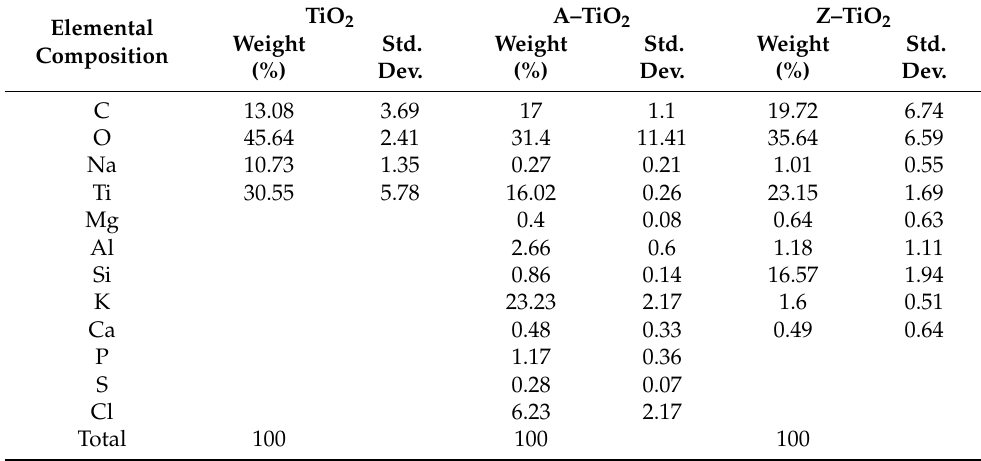
Table 1. Elemental distribution of TiO 2 , A–TiO 2 , and Z–TiO 2 for their average spectra (Figure